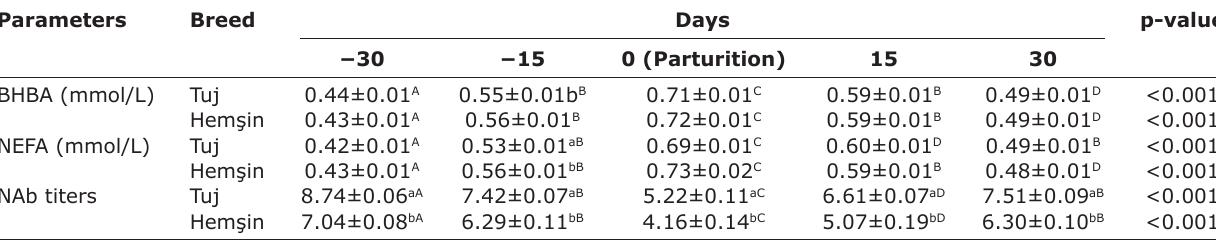
Table-2: Serum NAb titers and BHBA and NEFA concentrations in Tuj (n=25) and Hemşin (n=25) sheep during prepartum and postpartum periods. Parameters